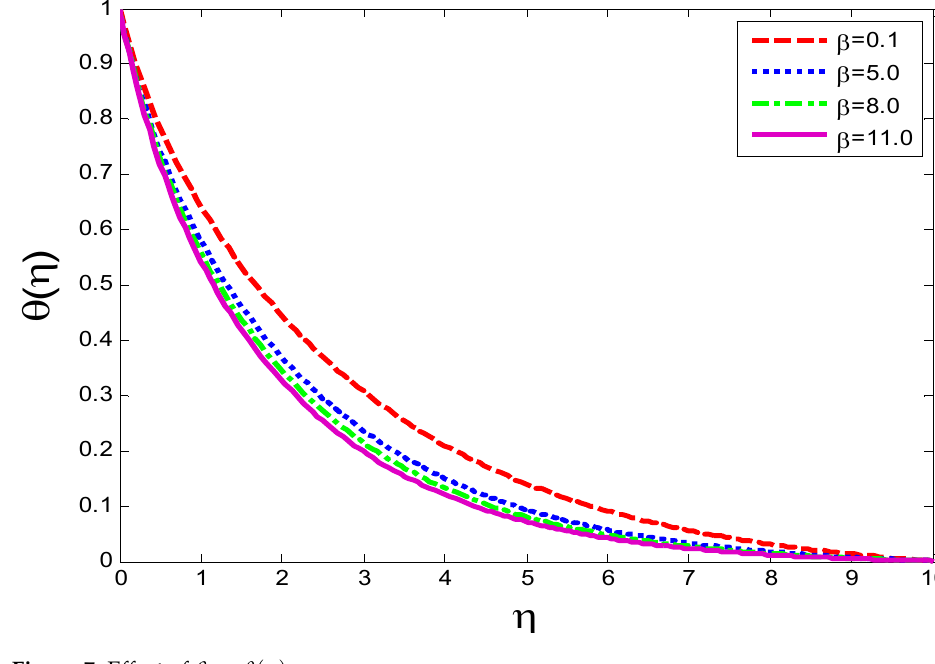
Figure 7. Effect of β on θ ( η ) .